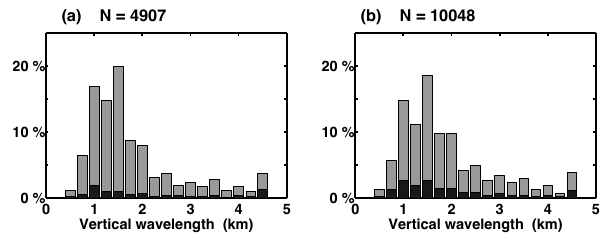
Figure 7. Distribution of vertical wavelengths for summer (a) and winter (b) season. Grey and black parts of the histogram represent the upward and downward energy propagating IGWs respectively.